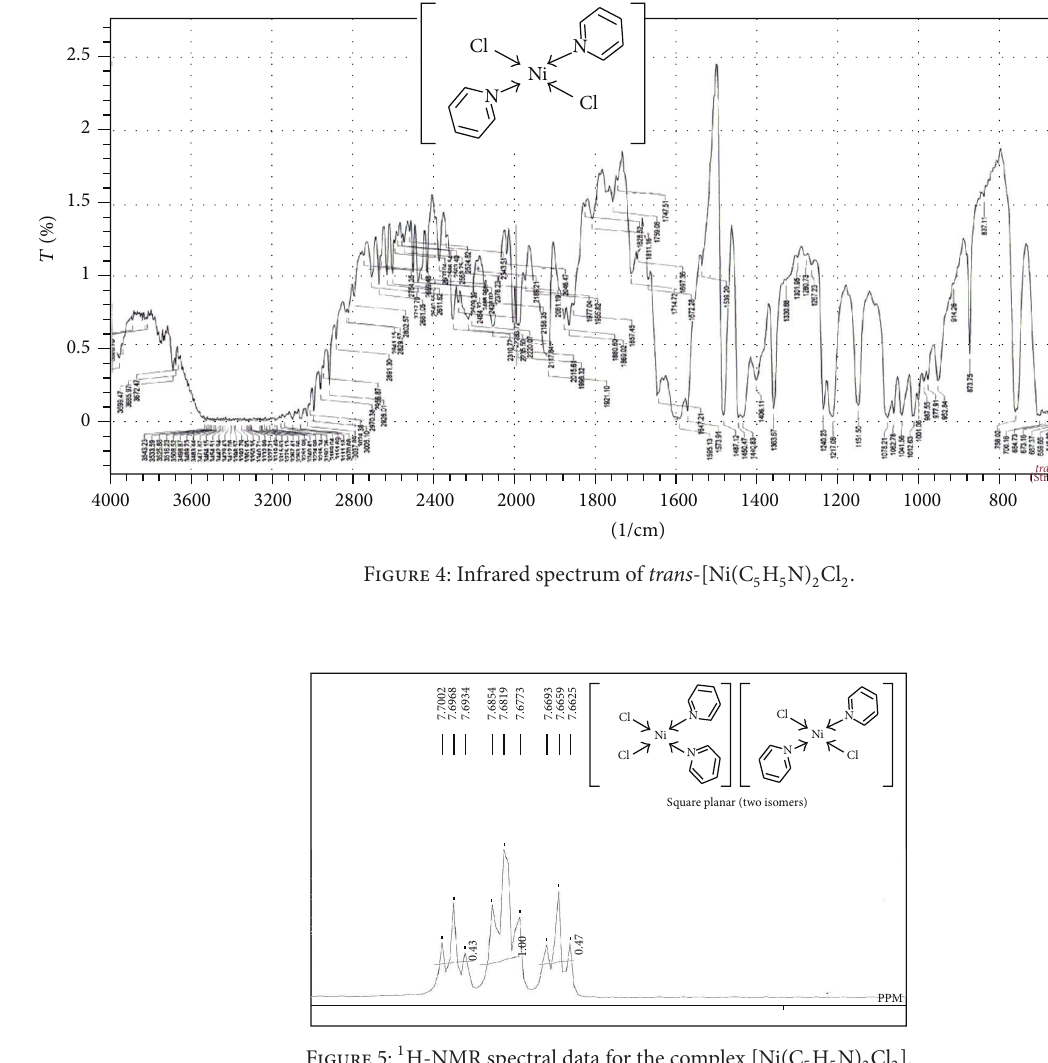
Figure 5: 1 H-NMR spectral data for the complex [Ni(C 5 H 5 N) 2 Cl 2